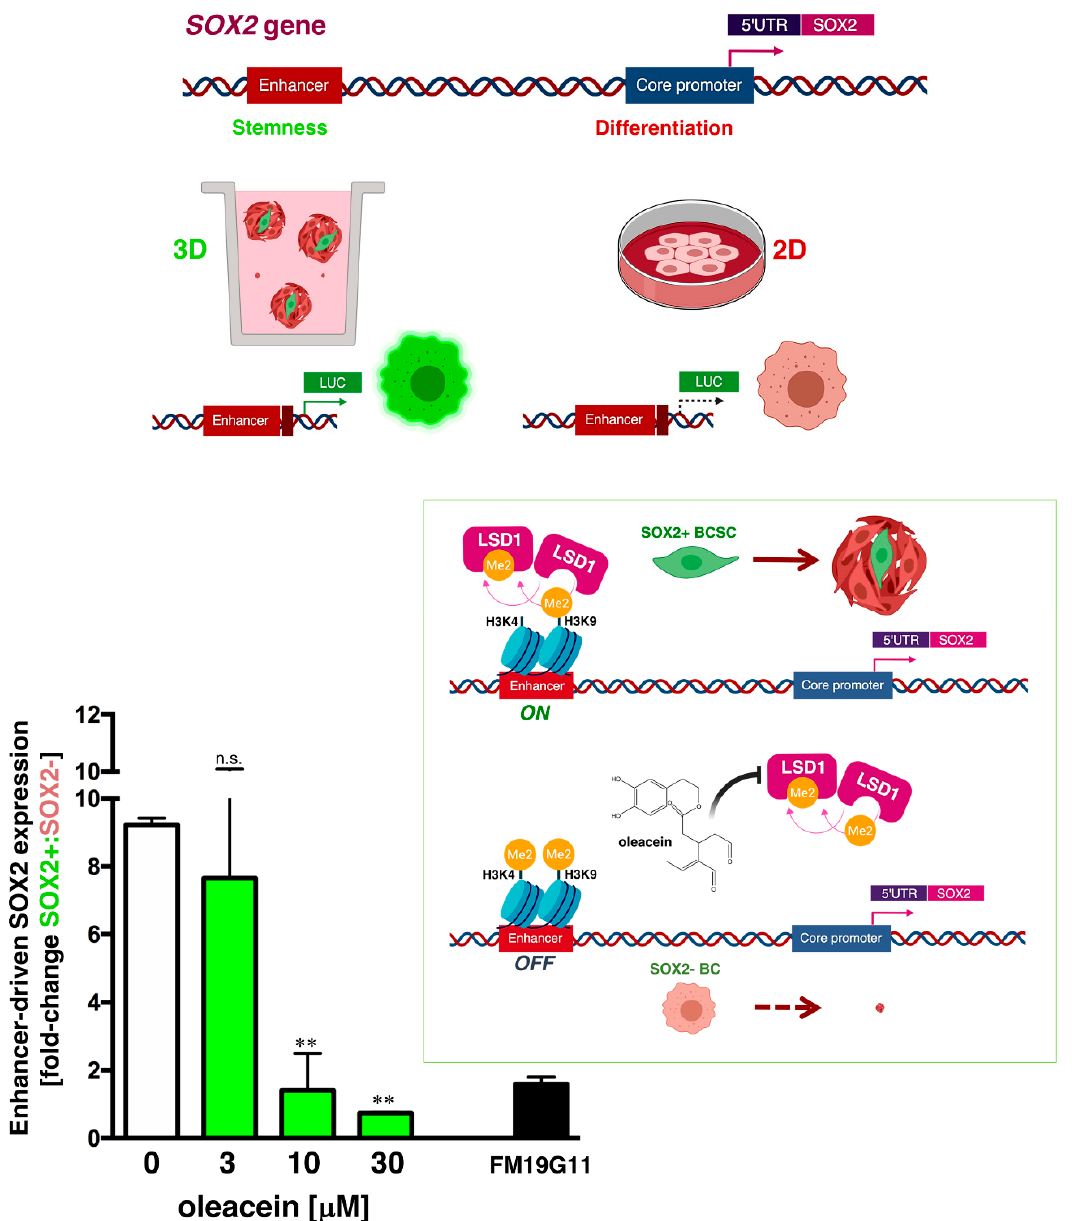
Figure 4. Oleacein suppresses LSD1-dependent, enhancer-driven expression of SOX2 in cancer stem cells. Top. Schematic representation of SOX2 promoter structure indicating the proximal core promoter region and the location of the distal enhancer, which is induced exclusively upon CSC-driven mammosphere formation but not in cell-adherent di ff erentiating conditions. Bottom. Results